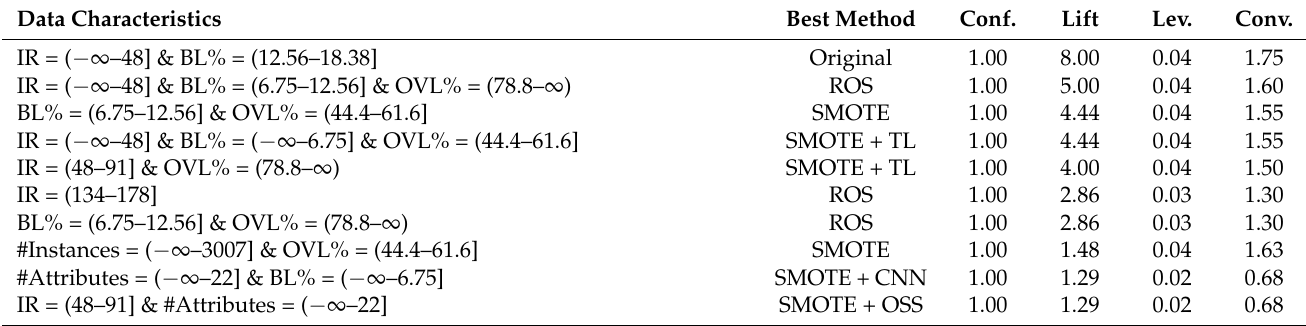
Table 3. Evaluation of the best method by means of association